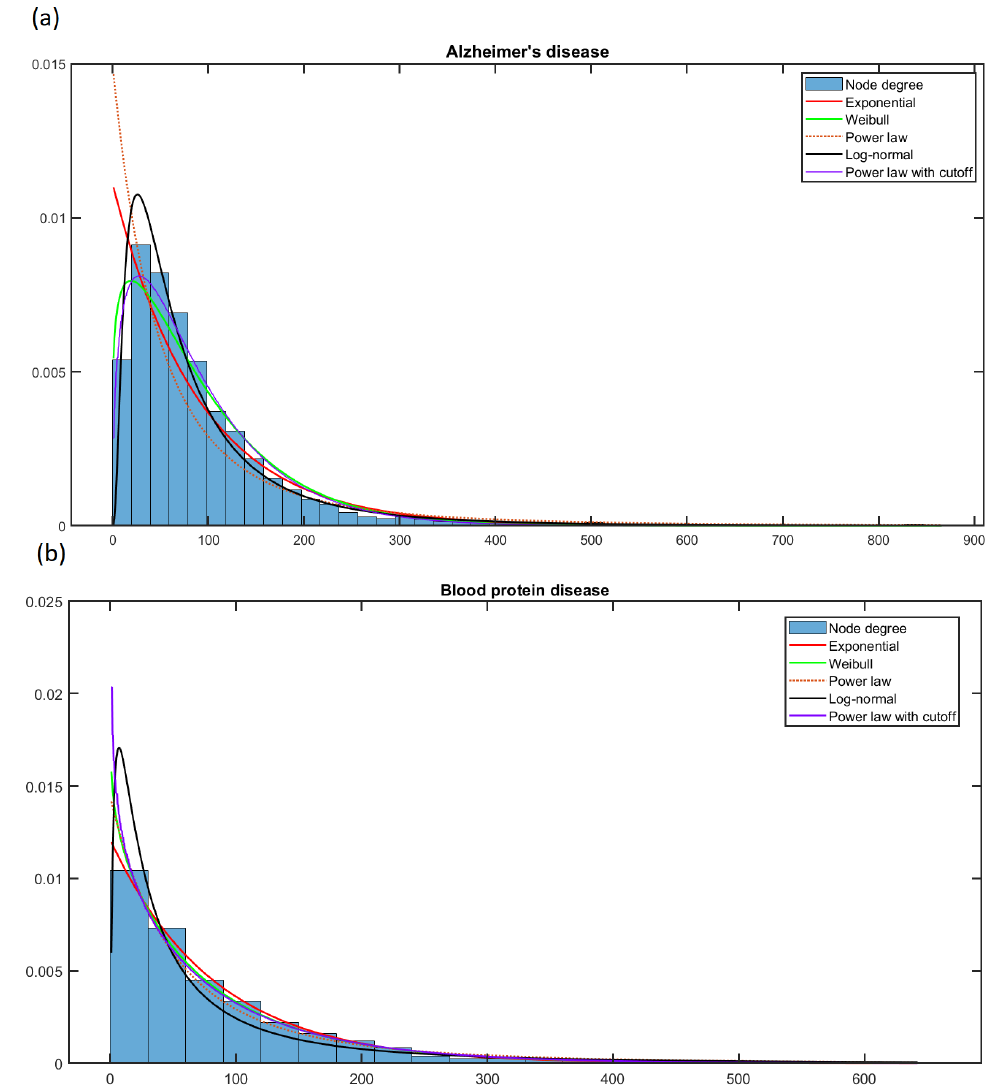
Figure 4. The fit of several models for the node degree probability distribution of ( a ) Alzheimer’s network and ( b ) blood protein disease